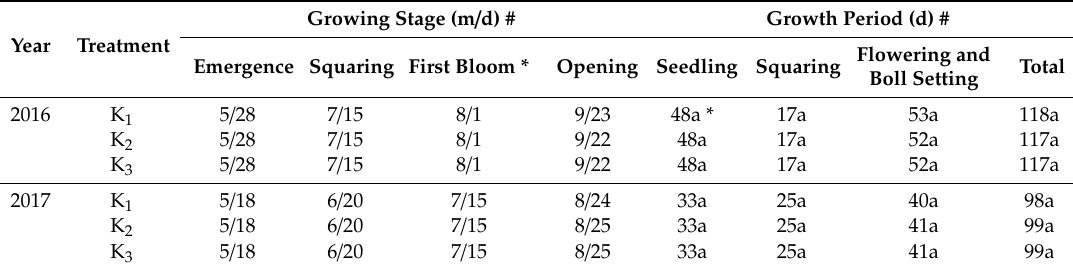
Table 1. Cotton growth stages and periods influenced by K fertilizer